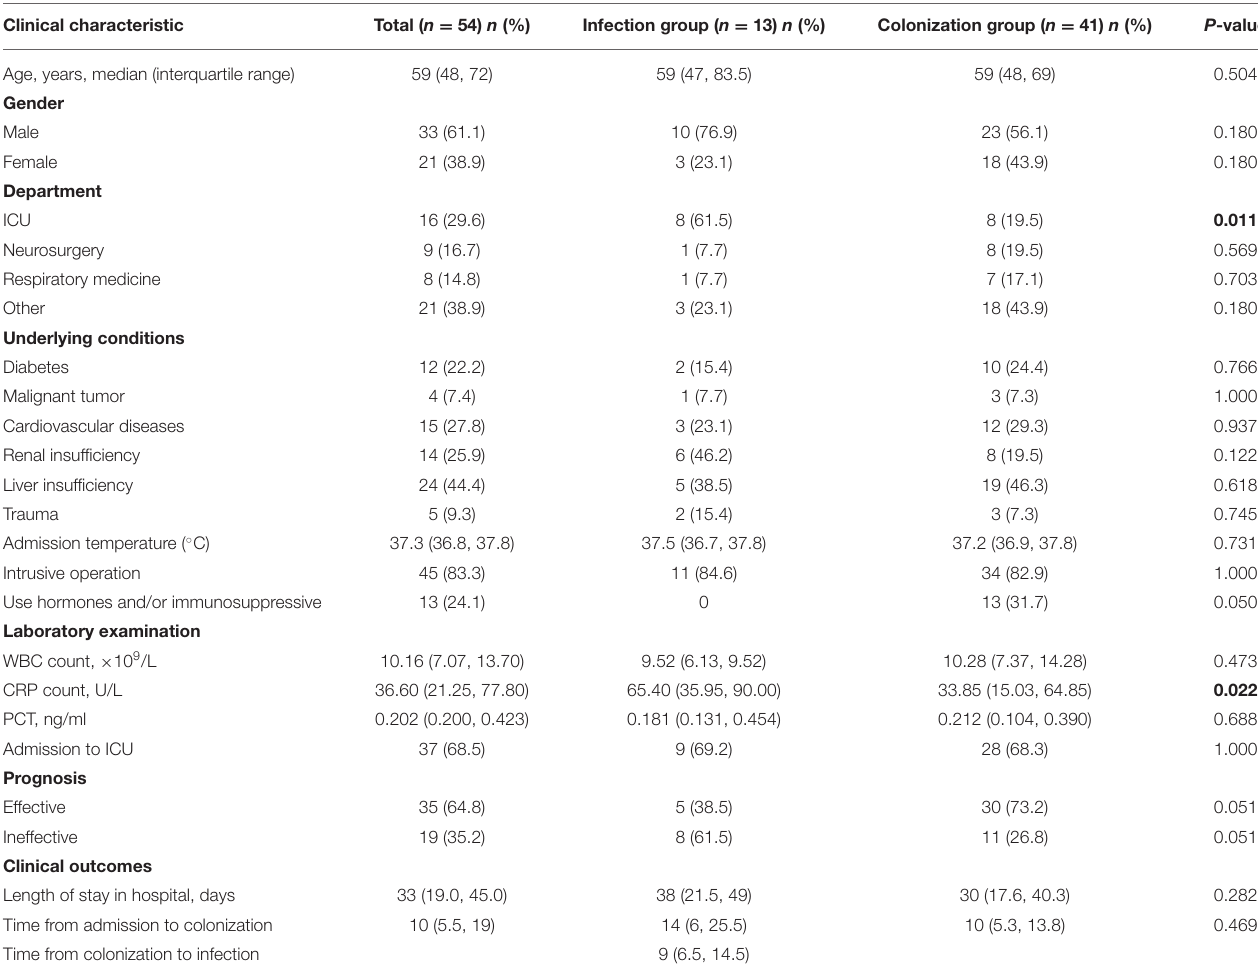
TABLE 2 | Clinical characteristics of 54 patients with intestinal colonization CRKP.